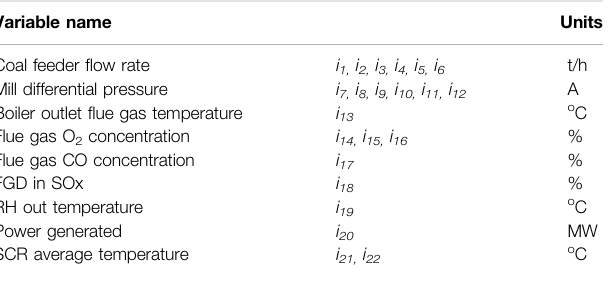
TABLE 1 | Data collected for modeling